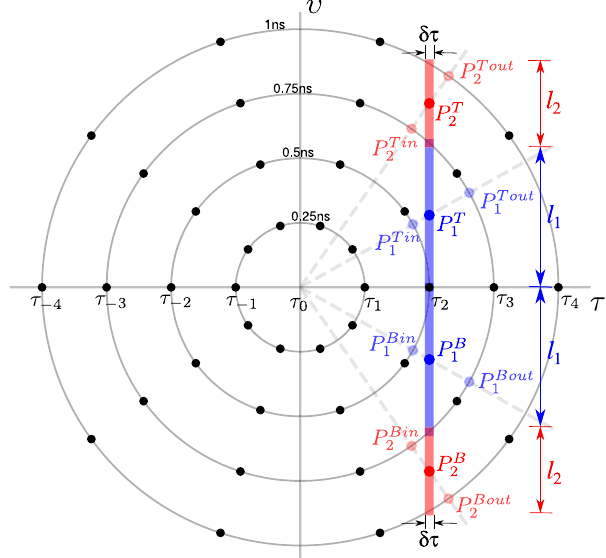
FIG. 3. Auxiliary figure supporting the explanation on how to express the longitudinal bunch profile at ð τ ¼ τ 2 ; υ ¼ 0 Þ as a function of the local joint probability